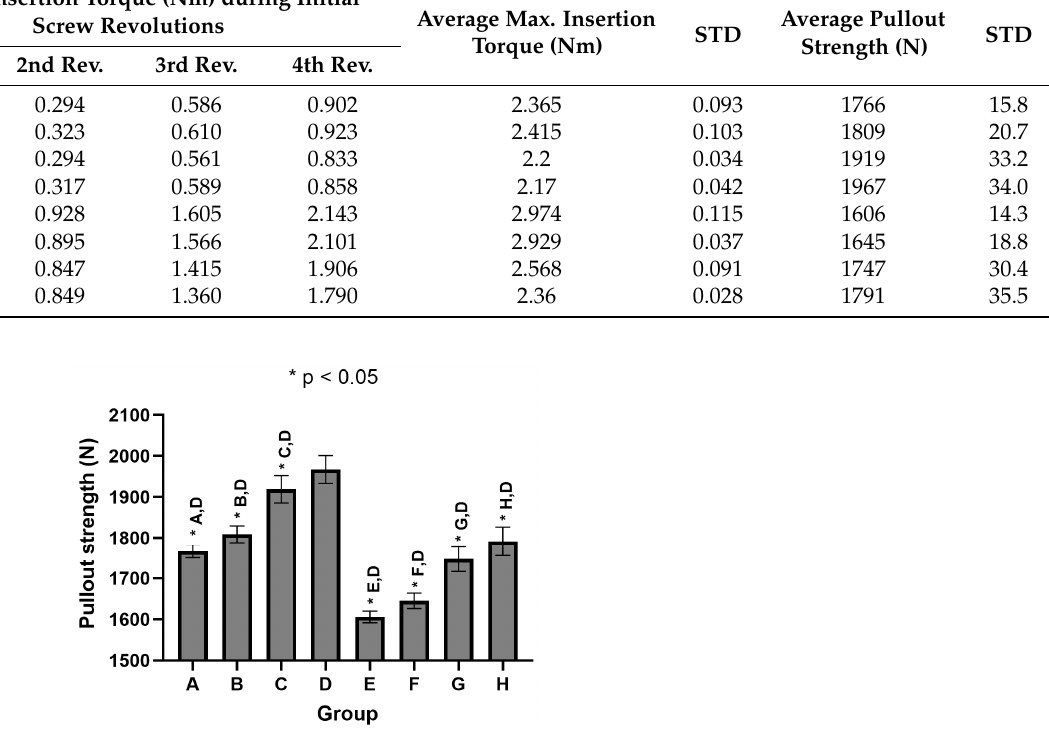
Figure 5. A bar chart of the pullout strength for each screw design. Error bars represent plus or minus one standard deviation.